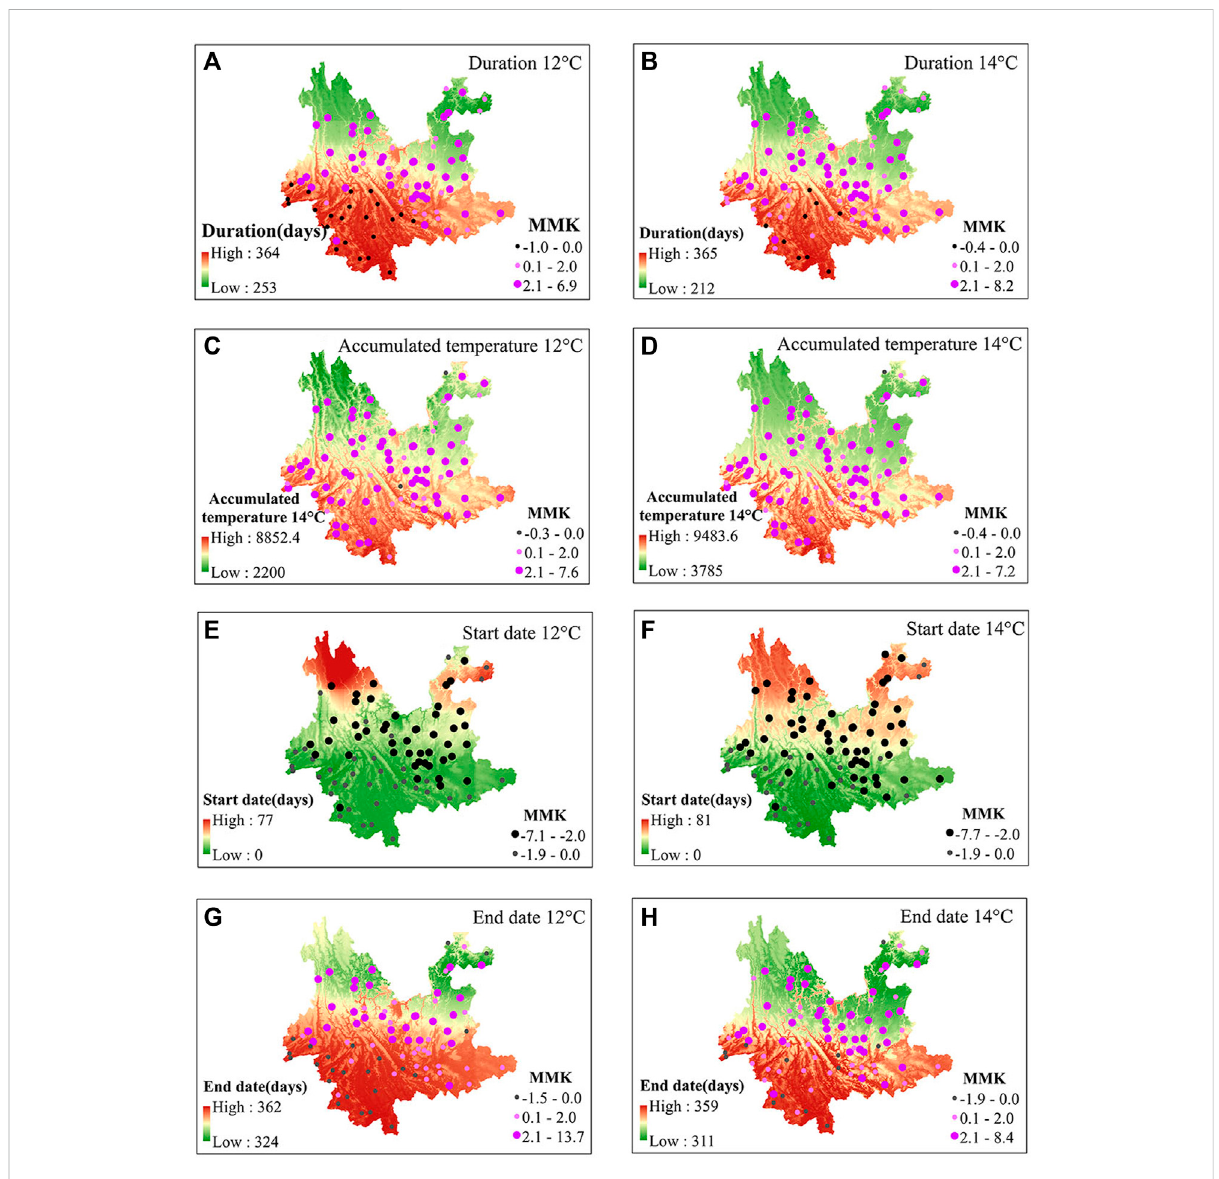
FIGURE 14 Spatial variation of (A,B) beginning date, (C,D) end date (E,F) duration, and (G,H) accumulated temperature of daily soil temperature ≥ 12 and 14 ° C at 5-cm